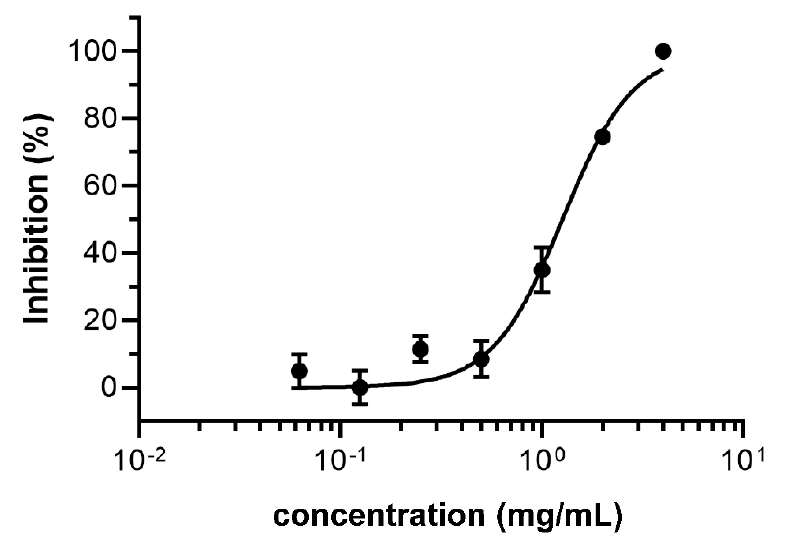
Figure 2. Dose-response curve of SB on SARS-CoV-2 M pro . SB inhibited SARS-CoV-2 M pro with half-maximal inhibitory concentration (IC 50 ) of 1.27 mg/mL and Hill slope of 2.5.